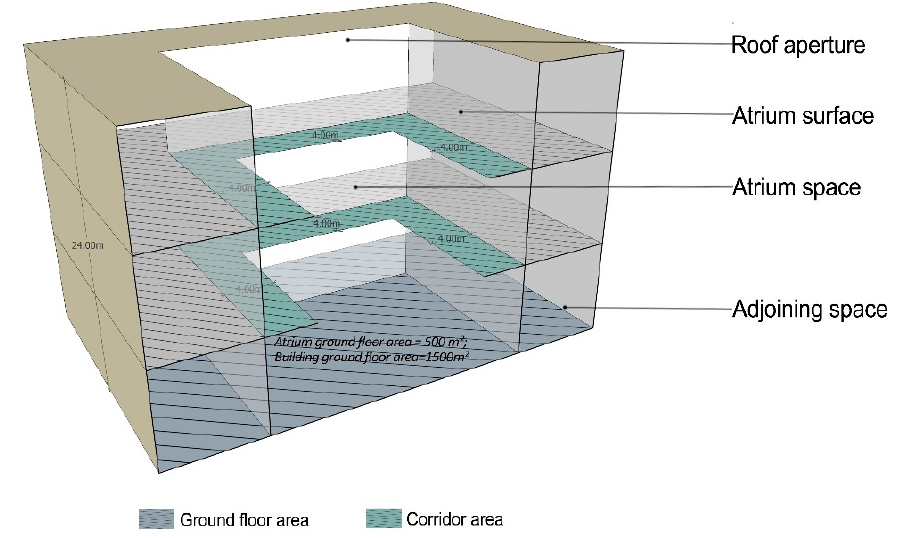
Figure 2. Diagram of a sample model section.